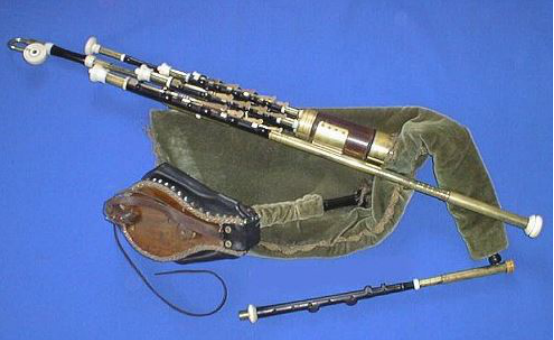
Figure 7. Full set of of the Irish national bagpipes: the Uilleann pipes [18].